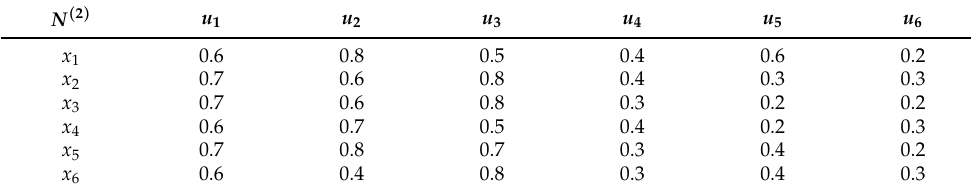
Table 7. Normalized decision matrix of expert e 2